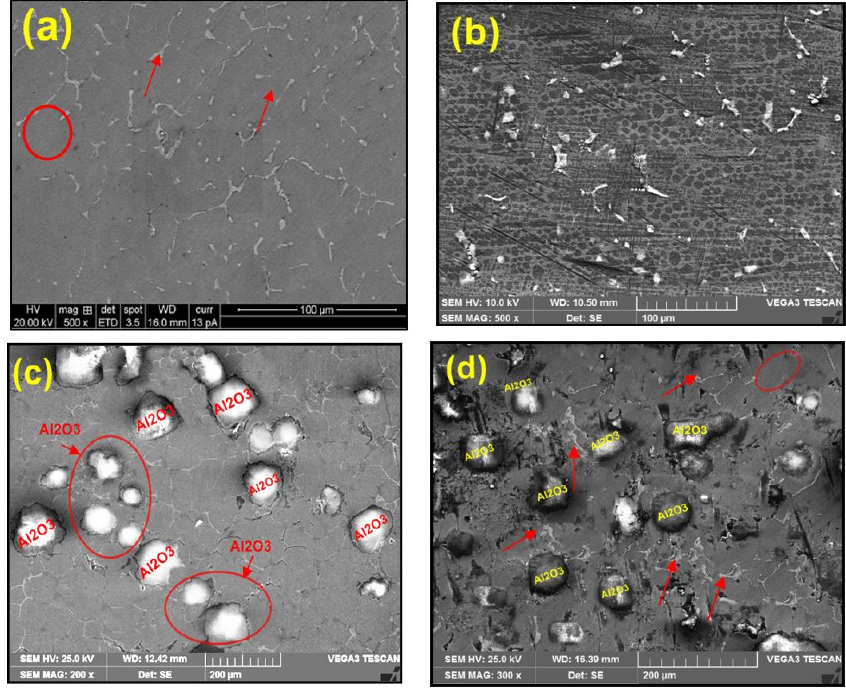
Figure 1. ( a – d ) SEM microphotographs of ( a ) as-cast Al2014 alloy ( b ) as-cast T6 heat-treated Al2014 alloy ( c ) as-cast Al2014-15 wt.% Al 2 O 3 and ( d ) Al2014-15 wt.% Al 2 O 3 both at room and T6 heat-treated, respectively.